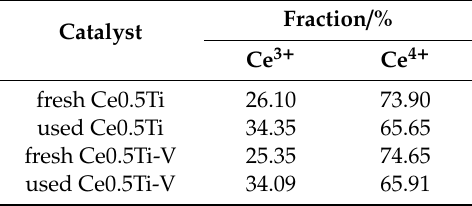
Table 6. The fraction of each type of cerium.